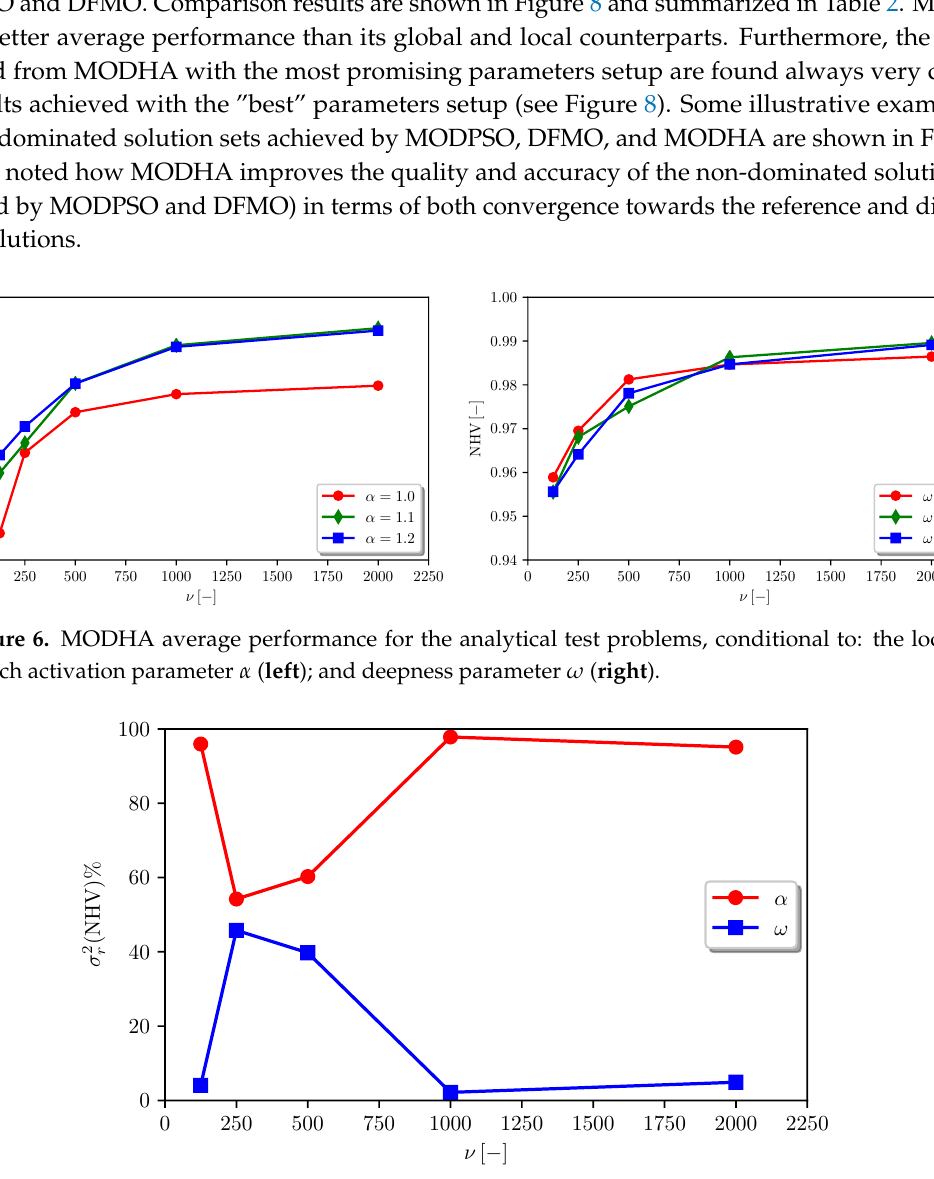
Figure 7. Normalized hypervolume relative variability of MODHA parameters ( α and ω ) for the analytical test